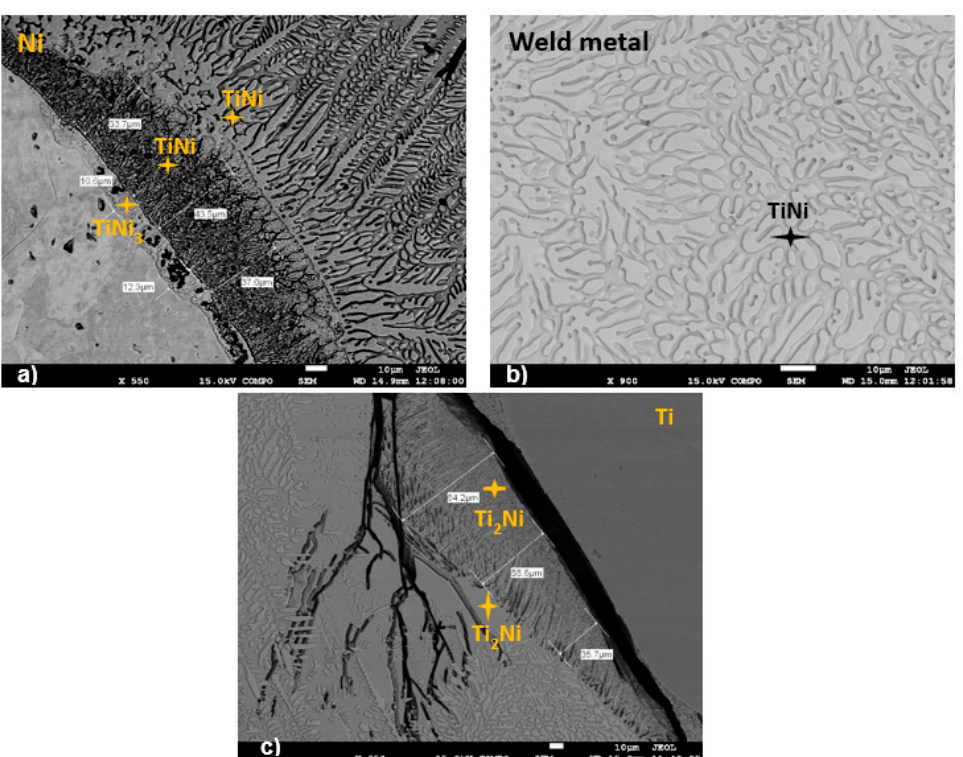
Figure 11. SEM analysis of the Ni–HAZ–weld metal of weld 10 ( a ); higher magnification of weld metal interface ( b ); weld metal–Ti HAZ interface ( c ).